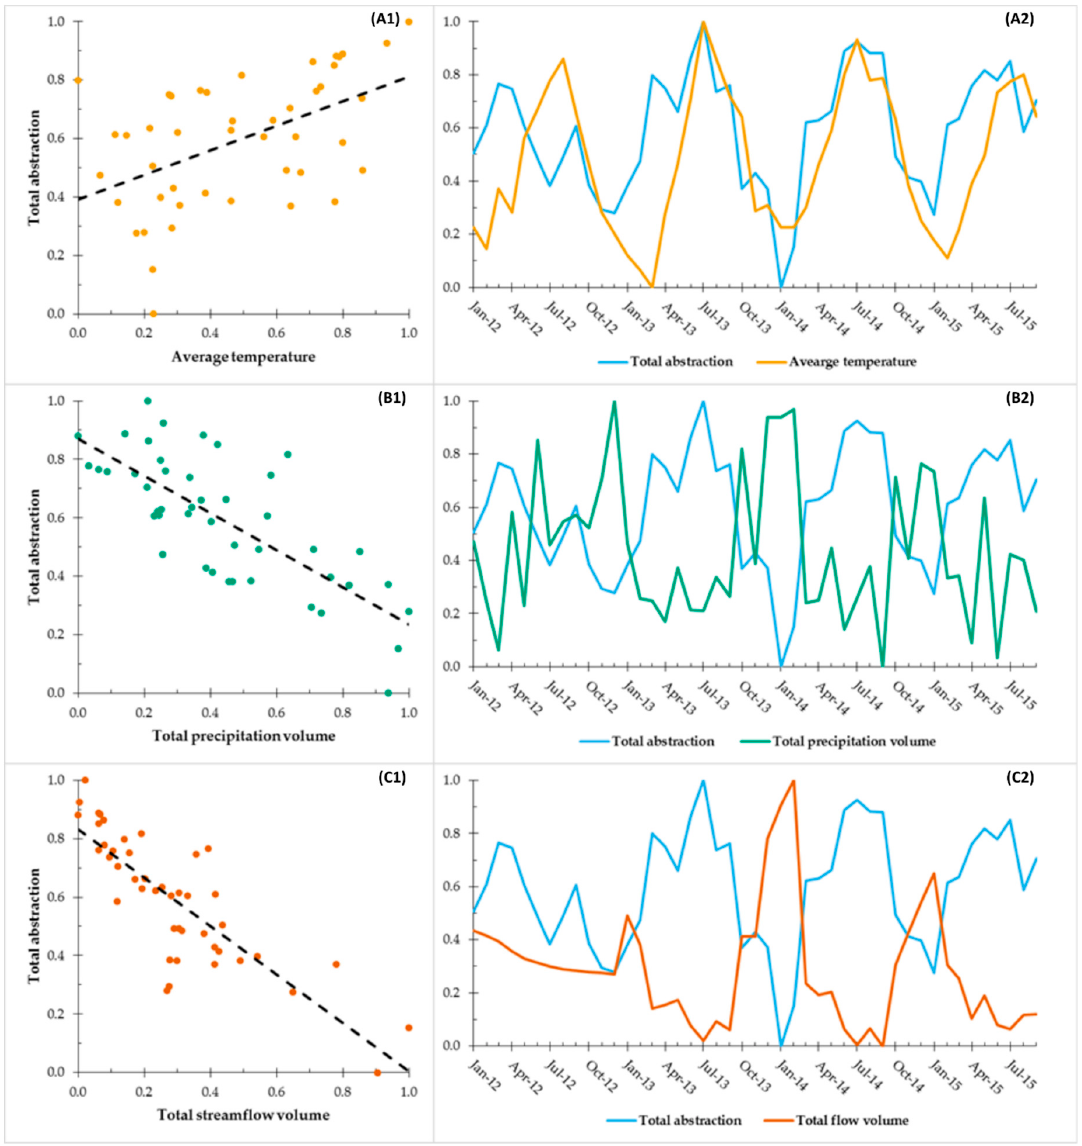
Figure 7. Normalized monthly hydroclimatic data compared with normalized monthly abstraction data for the period January 2012 to September 2015, for all study catchments combined. ( A1 , B1 , C1 ) Paired comparison, with black dashed lines representing trend direction; ( A2 , B2 , C2 ) time series comparison. Combined data is based on an average across all catchments for temperature, while precipitation, streamflow and abstraction volumes are all total volumes summed from all catchments.